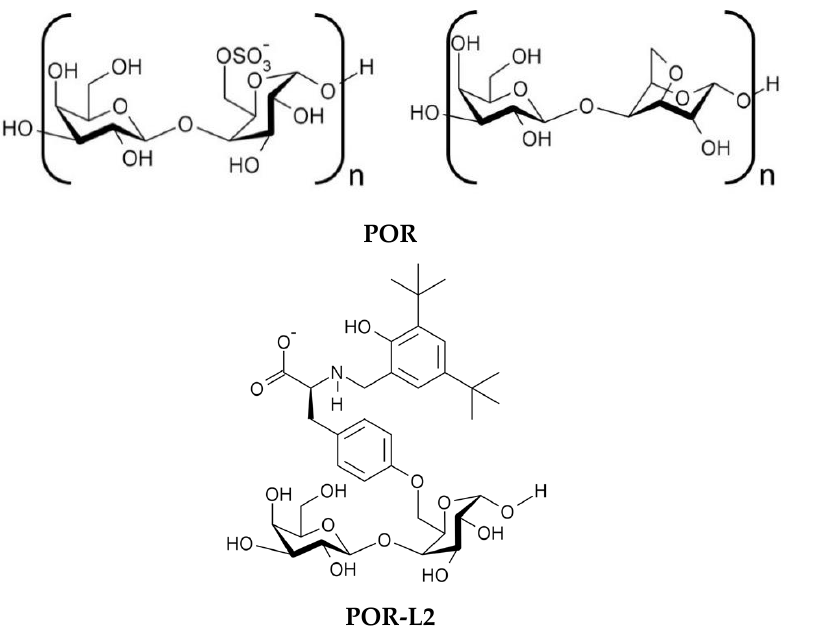
Figure 2. Structural formulas of the main repeating units of POR and the proposed structural formula of the modified porphyran POR-L2 .